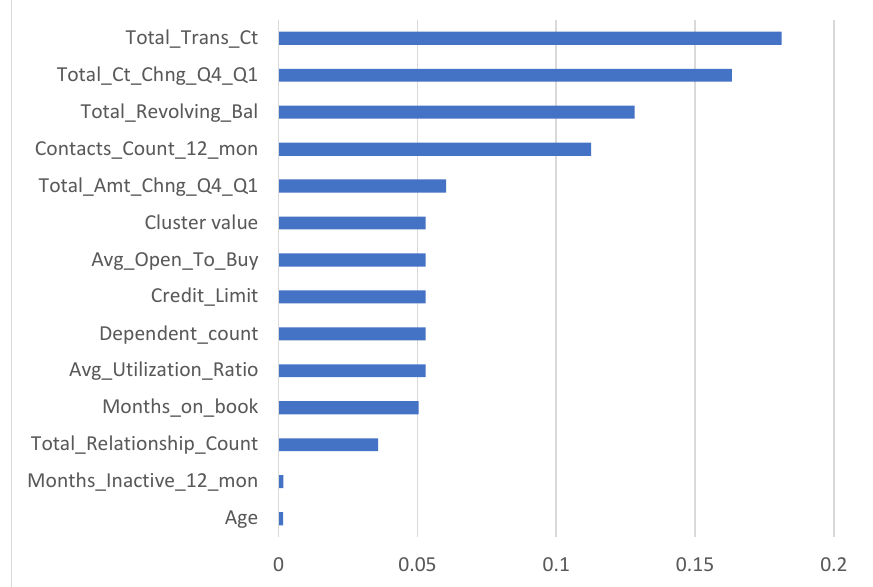
Figure 4. The importance of the variables for Model 2 after applying C5 tree model.